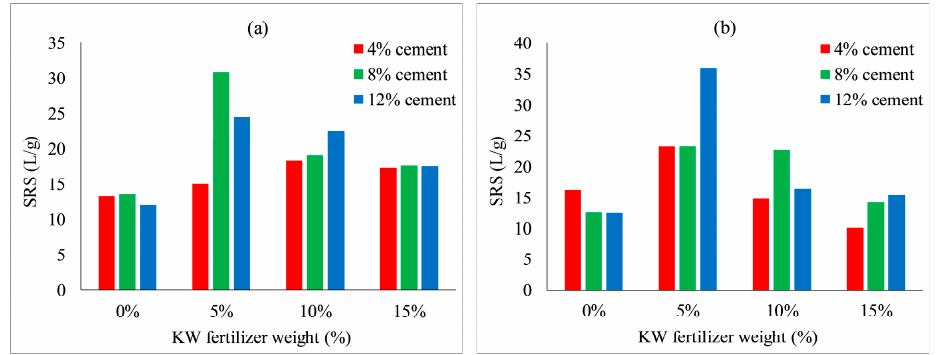
Figure 17. Scouring resistance of VC relative to KW fertilizer content: ( a ) Ryegrass ; ( b ) Festuca elata .